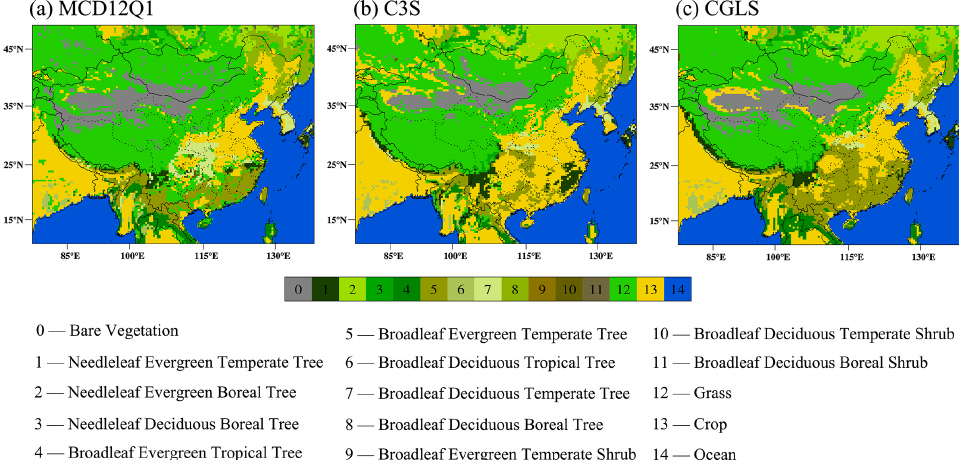
Figure 1. Simulation domain with the spatial distribution of major PFTs in each grid.